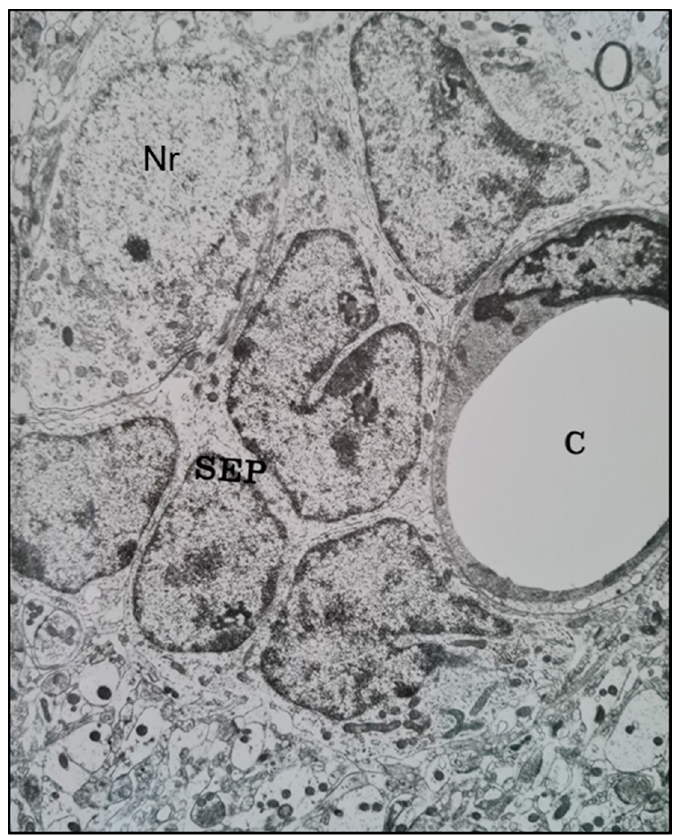
Figure 2. A transmission electron microscope micrograph of the sub-ventricular zone of the brain of a trans placentally ENU-treated BDIX rat showing neoplastically-transformed sub-ependymal plate glial stem cells (SEP) closely juxtaposed with a brain capillary (C) (right) and a neuronal cell body (Nr) (upper left). ×10,800.